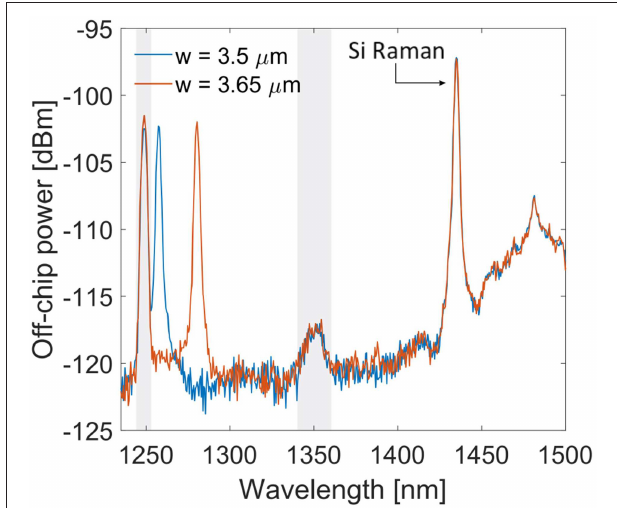
FIGURE 8 | Spectra of the generated idler for the 1331TE inter-modal phase-matching combination in spontaneous FWM. Different waveguide widths are considered (width values in legend). The peak at 1,434nm is the anti-Stokes Raman from silicon. The broad peak at 1,475nm is the anti-Stokes Raman due to the silica input fiber. The gray boxes highlight spurious peaks.